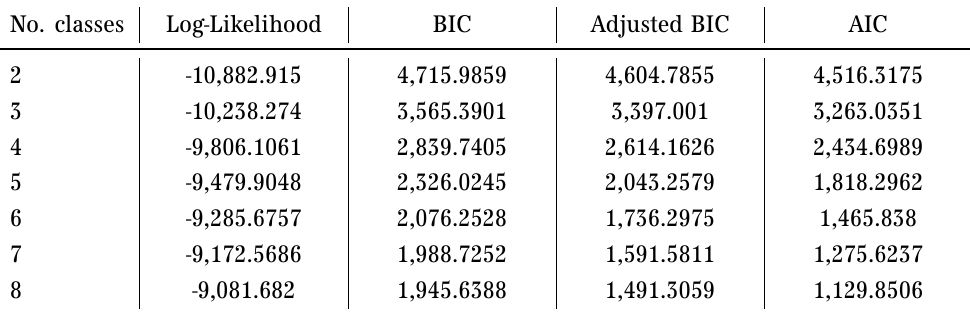
Table 4: Information criteria of competing LCA